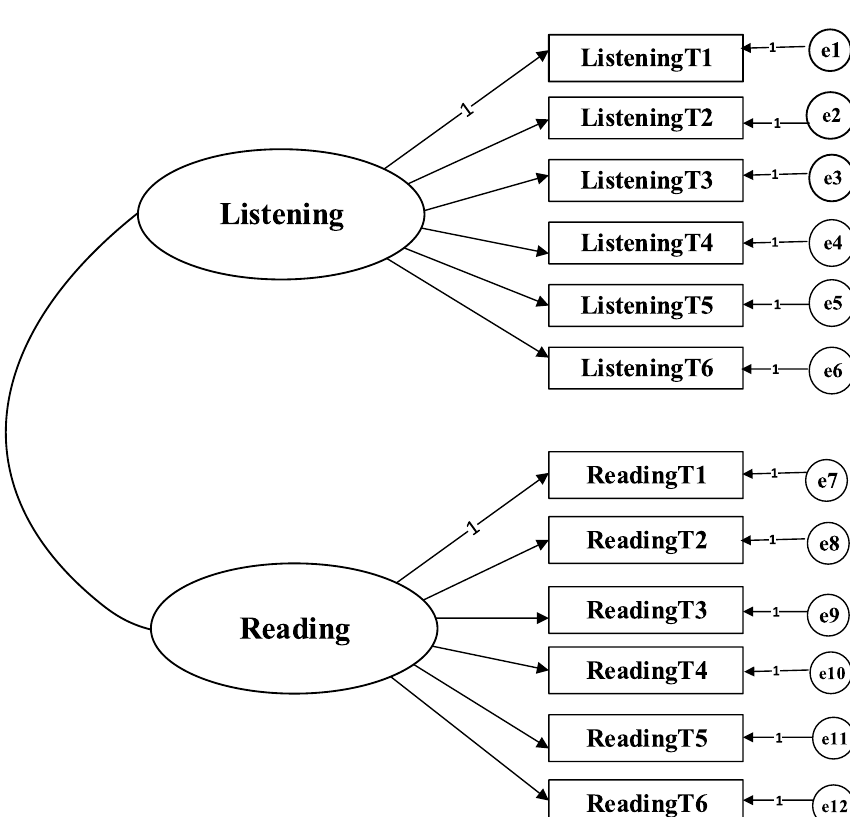
Fig. 3 Correlated model. Note: The ovals represent latent variables/factors; the circles, measurement errors/ residuals; and the rectangles, observed